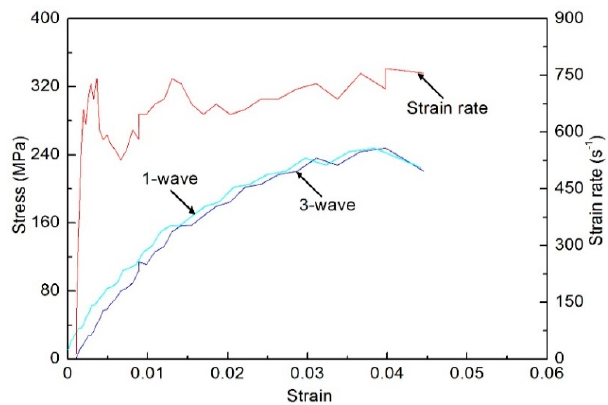
Figure 6. Analysis of stress uniformity for a specimen with a temperature of 288 K under dynamic compression.